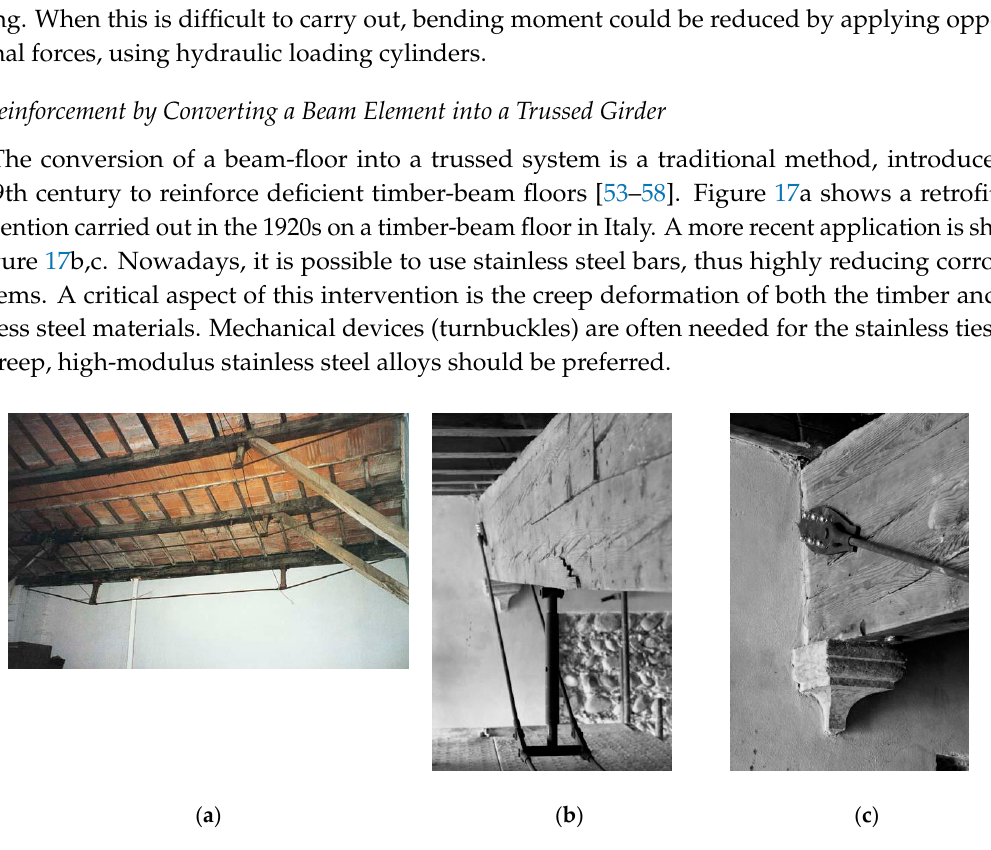
Figure 17. Examples of bending reinforcement by conversion of a timber-beam floor into a trussed girder by adding steel struts and tension rods underneath ([53] for ( b ) and ( c )).